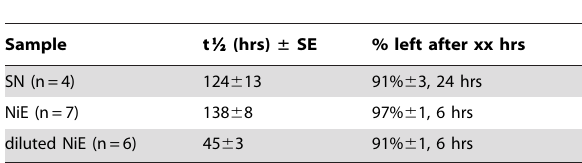
Table 1. Stability of NTS1 in the absence of